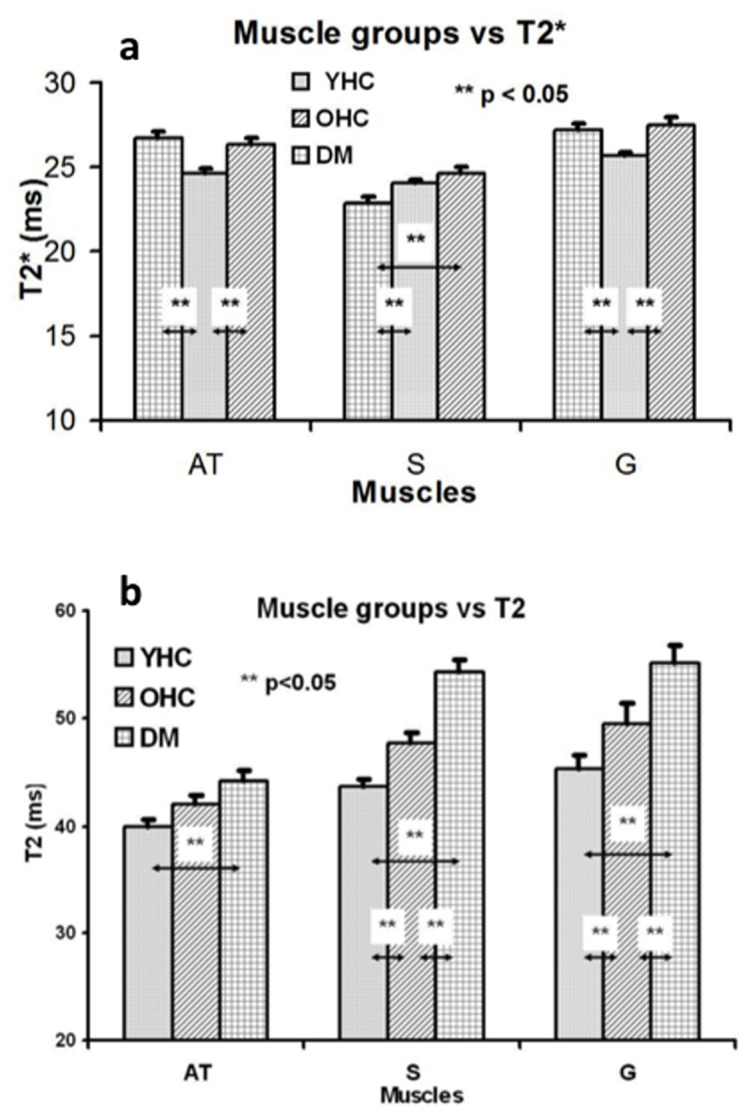
a. T2* distribution among anterior tibialis, soleus, and gastrocnemius of young healthy controls (YHC), older age-matched healthy controls (OHC), and T2DM subjects (DM). The error bars represent the standard errors of the means. The difference between the control and the T2DM soleus is significant. The difference between the AT and S is not significant in healthy controls, but it is in T2DM subjects. b. T2 distribution among anterior tibialis, soleus, and gastrocnemius of young healthy controls (YHC), older age-matched healthy controls (OHC), and T2DM (DM). The error bars represent the standard errors of the means. The difference between the control and the T2DM soleus is significant. Compared to T2*, the most dramatic difference is the much longer T2 of the diabetic soleus than observed in either the young or older healthy controls.